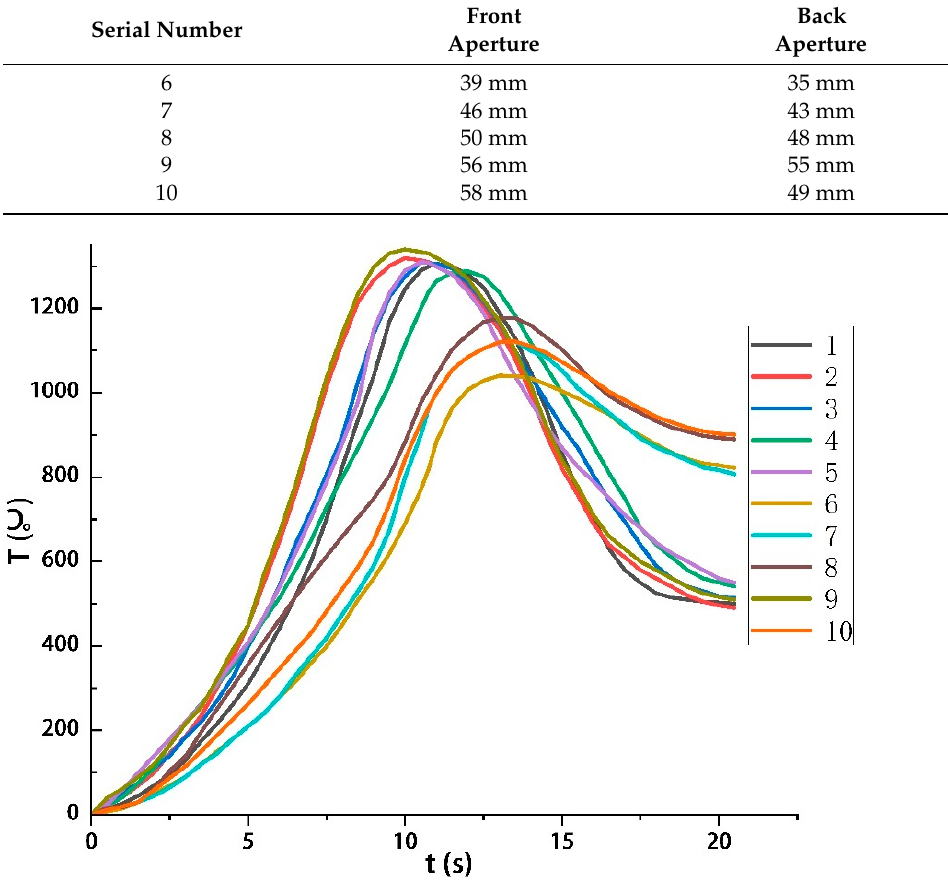
Table 2. Perforation sizes of the steel targets.